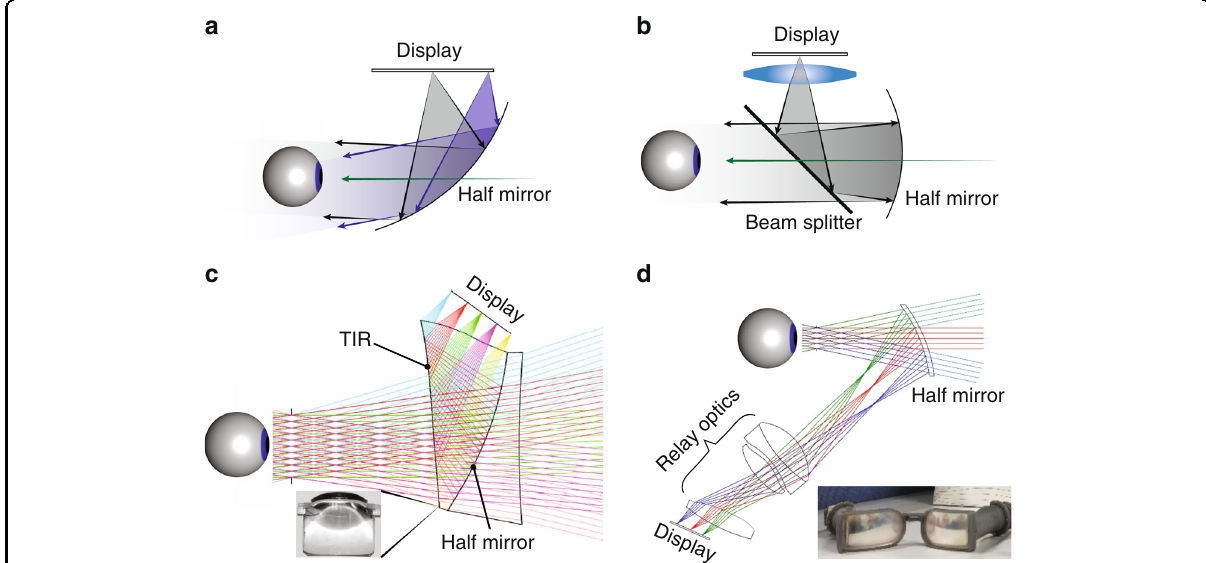
Fig. 8 AR combiners based on geometric optical designs. a Single freeform surface as the combiner. b Birdbath optics with a beam splitter and a half mirror. c Freeform TIR prism with a compensator. d Relay optics with a half mirror. Adapted from c ref. 149 with permission from OSA Publishing and d ref. 151 with permission from OSA